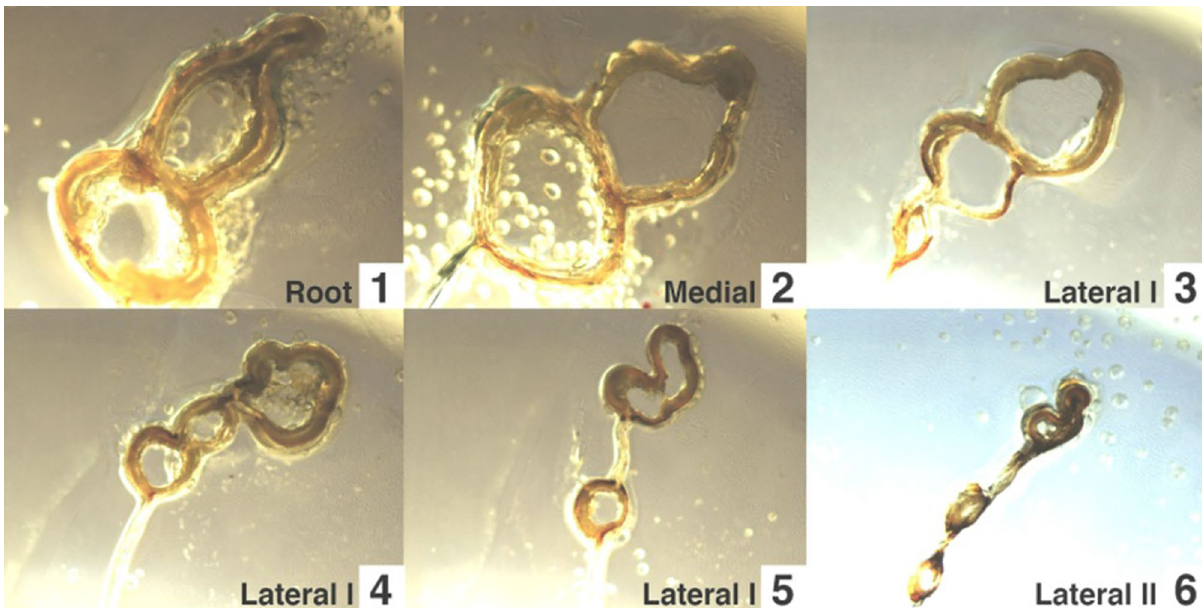
Figure 2. Cross sections of the Cicada 1 wing leading edge at different locations.